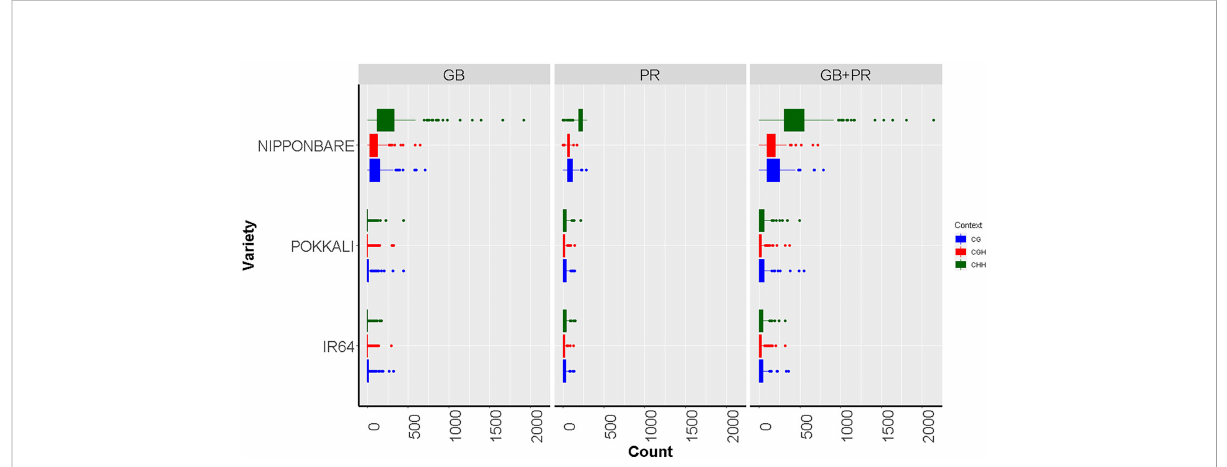
FIGURE 5 Boxplots showing methylated cytosine frequency in three sequence contexts: CG (blue), CHG (red), and CHH (green) among three different rice varieties with contrast responses to aluminum exposure: Nipponbare (Tolerant), Pokkali, and IR64 (Susceptible). The results are discriminated according to the location of the epigenetic mark, either inside the gene body region (GB), the promoter (PR), or both the promoter and inside the gene body region of analyzed genes (PR + GB). From (Gallo-Franco et al.,